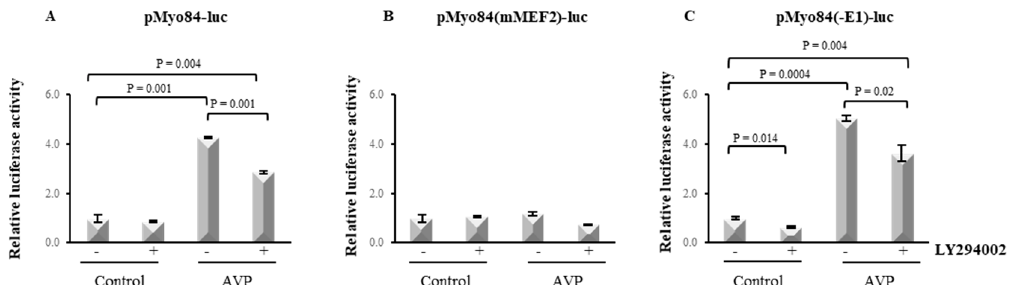
Figure 5. LY294002 inhibits the AVP-dependent activation of myogenin promoter through the MEF2 site. L6 cells were plated in growth medium and after 24 h were transiently transfected with ( A ) the luciferase reporter construct carrying the 84-bp sequence of the myogenin promoter carrying intact MEF2 and E-box sites or ( B ) with the same promoter mutated in the MEF2 site or ( C ) deleted of the E-box . After 24 additional hours, cultures were shifted to serum-free medium and treated with 0.1 µM AVP in the presence and in the absence of 20 µM LY294002 for 48 h. The luciferase activity was determined and normalized to β -gal activity as described in Materials and Methods. Statistical analysis was performed by Student’s t -test on data obtained from three independent